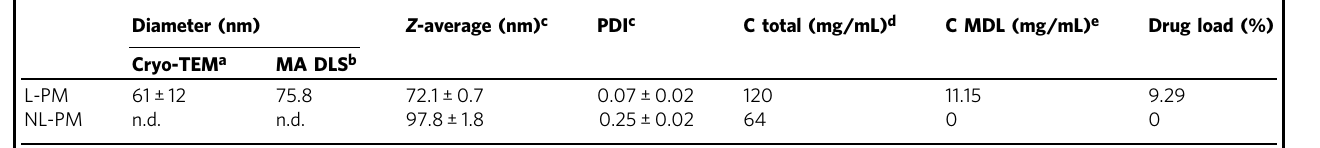
Errors indicate one std. deviation of multiple measurements (if applicable). a As determined by measuring two perpendicular axes of 33 particles with ImageJ. b As determined by multi-angle DLS (MA DLS). c As determined by single-angle Dynamic Light Scattering (SA DLS). d As determined by lyophilization of a portion of injected solutions. e As determined by